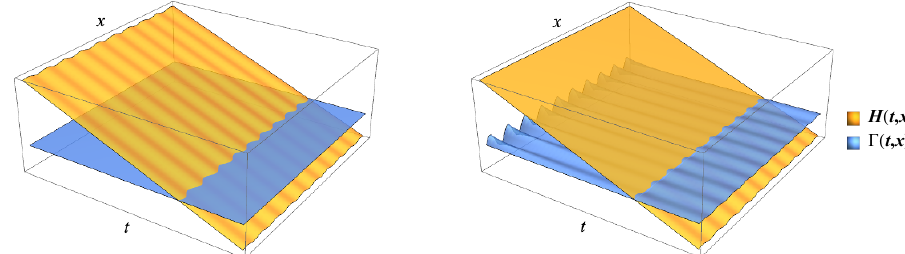
Figure 1 . The ordinary in(cid:13)ation scenario versus modulated reheating, illustrating the Hubble scale (orange) and the decay rate of the in(cid:13)aton (blue) as functions of time and space